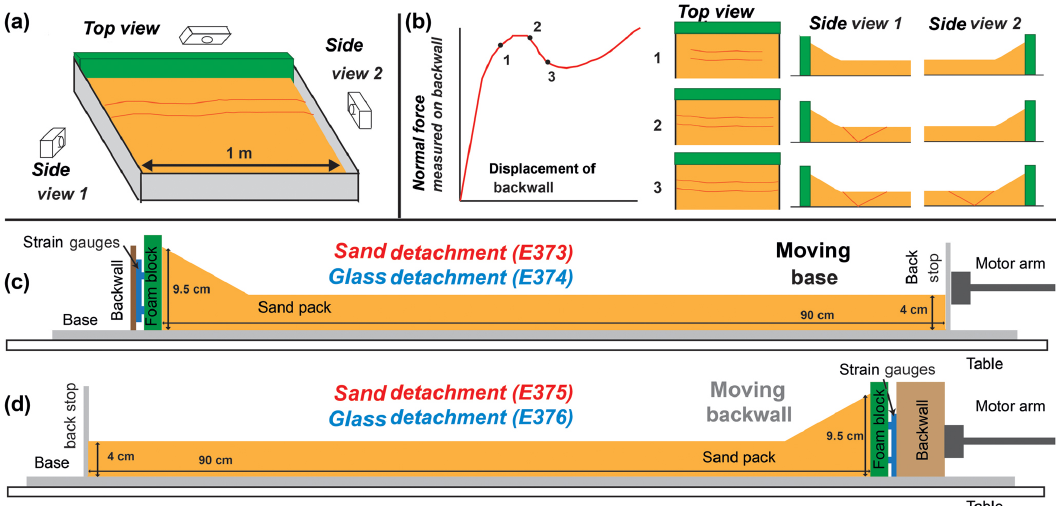
Figure 1. Schematics of experimental setup, force and faulting evolution. (a) Position of cameras relative to sand pack. Backwall and glass sidewalls are in green and gray. (b) Characteristic force curve and faulting events revealed through the top and side views. (c, d) Experiment apparatus configurations of each experiment. The four experiments differ in the apparatus configuration: (c) moving base (E373, E374) or (d) moving backwall (E375, E376), and the inclusion of basal glass bead